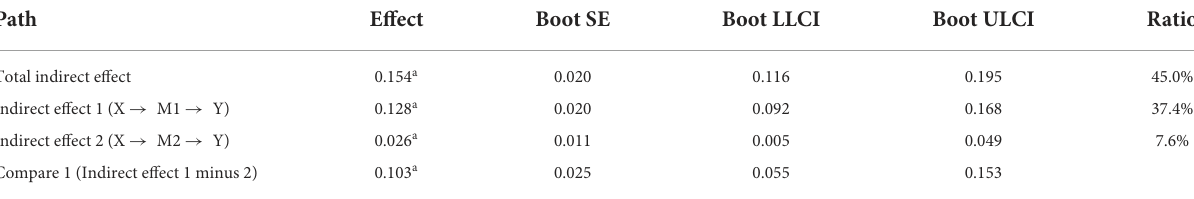
TABLE 4 The results of the multiple mediation model.